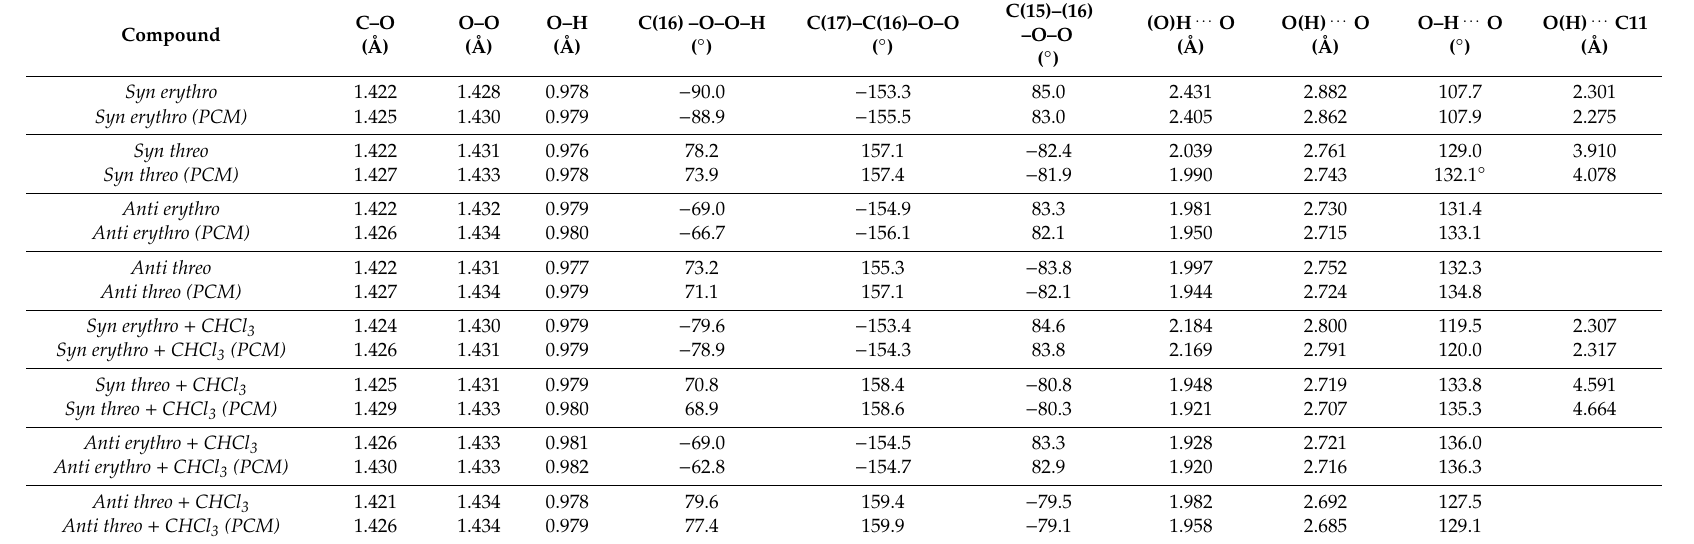
Table 1. Conformational and structural properties of two pairs of diastereomers of the model 9- cis , 11- trans -16-OOH endo -hydroperoxides with energy minimization using the APFD / 6-31 + G(d) method in the gas phase and with a discrete solvation molecule of CHCl 3 . Compound